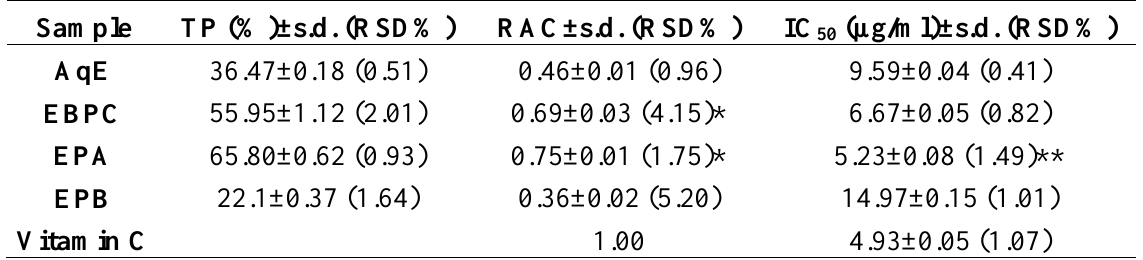
Table 1. Assessment of contents of total polyphenols (TP) and antioxidant capacity by the methods of the phosphomolybdenum complex (RAC) and DPPH-radical scavenging (IC 50